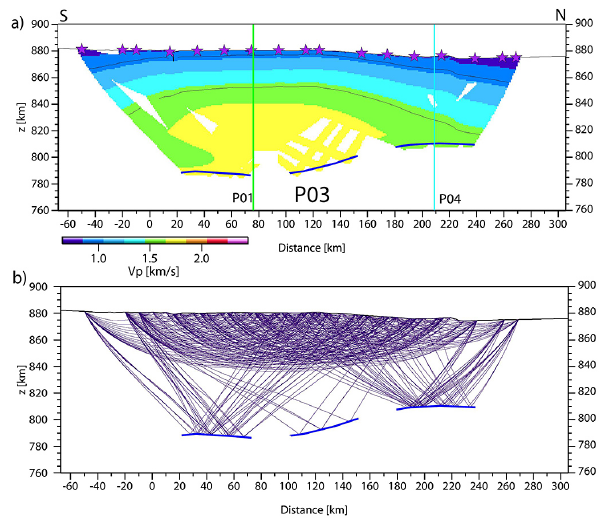
Figure 8. Results of seismic profile P3. (a) Final velocity model including the inverted reflector (blue line). Stars represent shot po- sitions. Zero distance represents position of the first geophone along the profile. The intersections between P3 with profiles P1 and P4 are also indicated (see Fig. 2). (b) Associated ray paths.